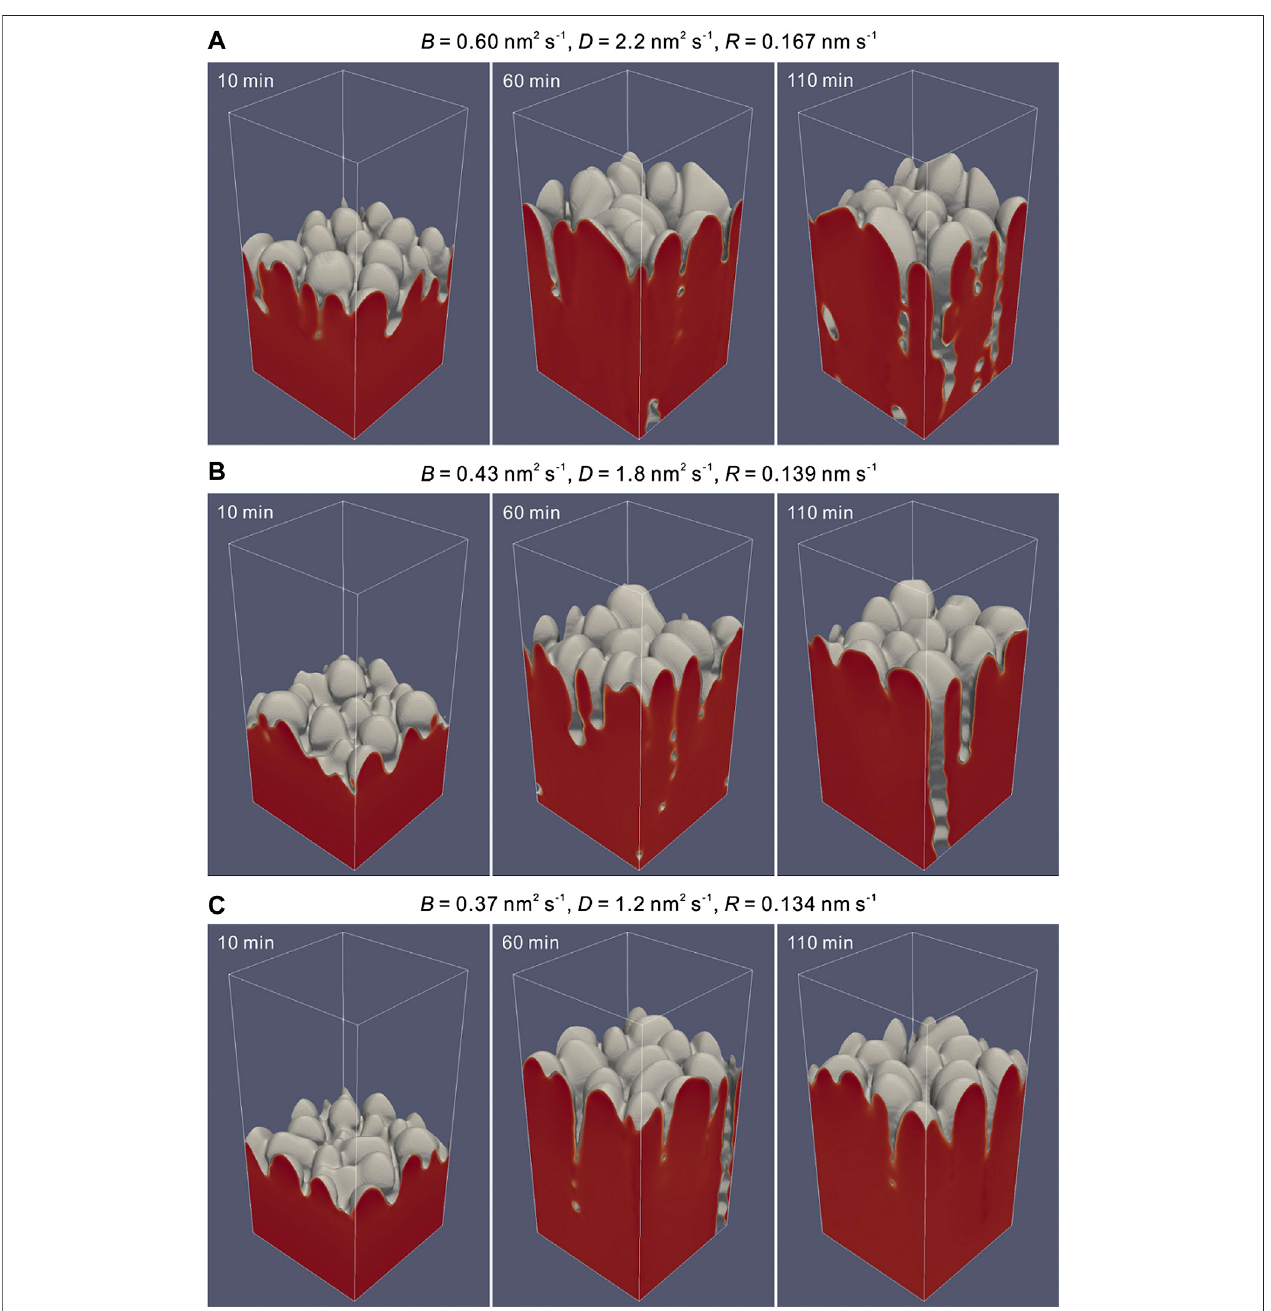
FIGURE 1 | Microstructure evolution of PVD TiN coatings due to 3D phase- fi eld simulations with different deposition rates (i.e., R ) corresponding to various sets of the vapor – solid transition velocity (i.e., B ) and diffusion coef fi cient (i.e., D ): (A) B = 0.60 nm 2 s − 1 , D = 2.2 nm 2 s − 1 , R = 0.167 nm s − 1 . (B) B = 0.43 nm 2 s − 1 , D